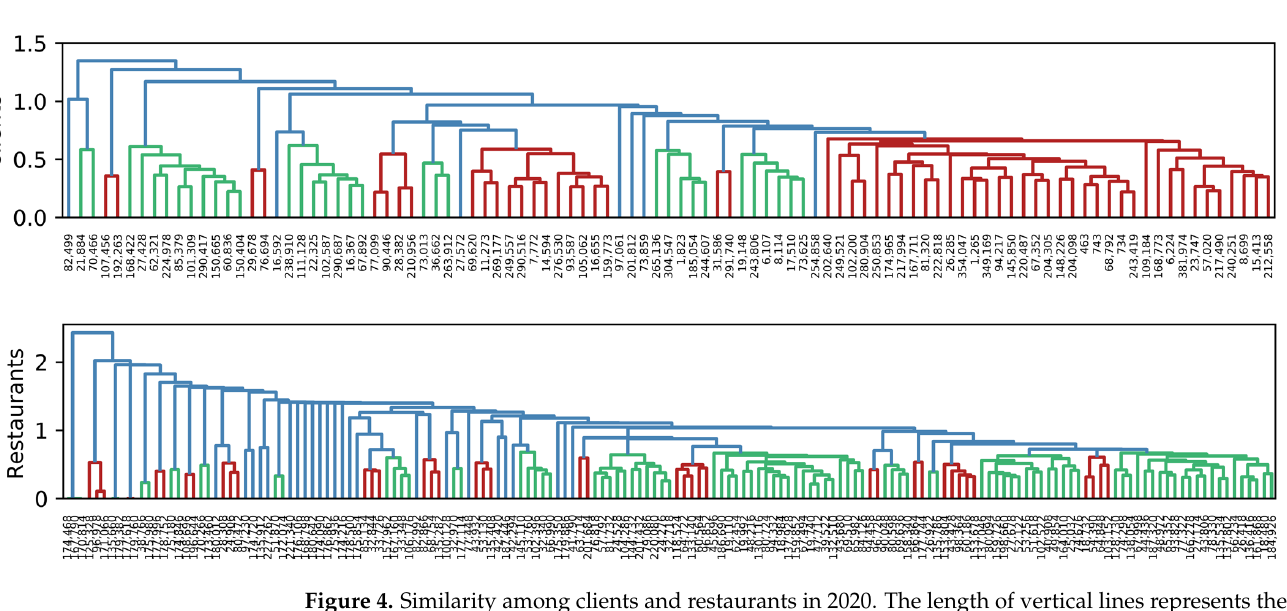
Figure 4. Similarity among clients and restaurants in 2020. The length of vertical lines represents the distance between items. The shorter the line, the closer the items. Different colors represent possible groups of items.